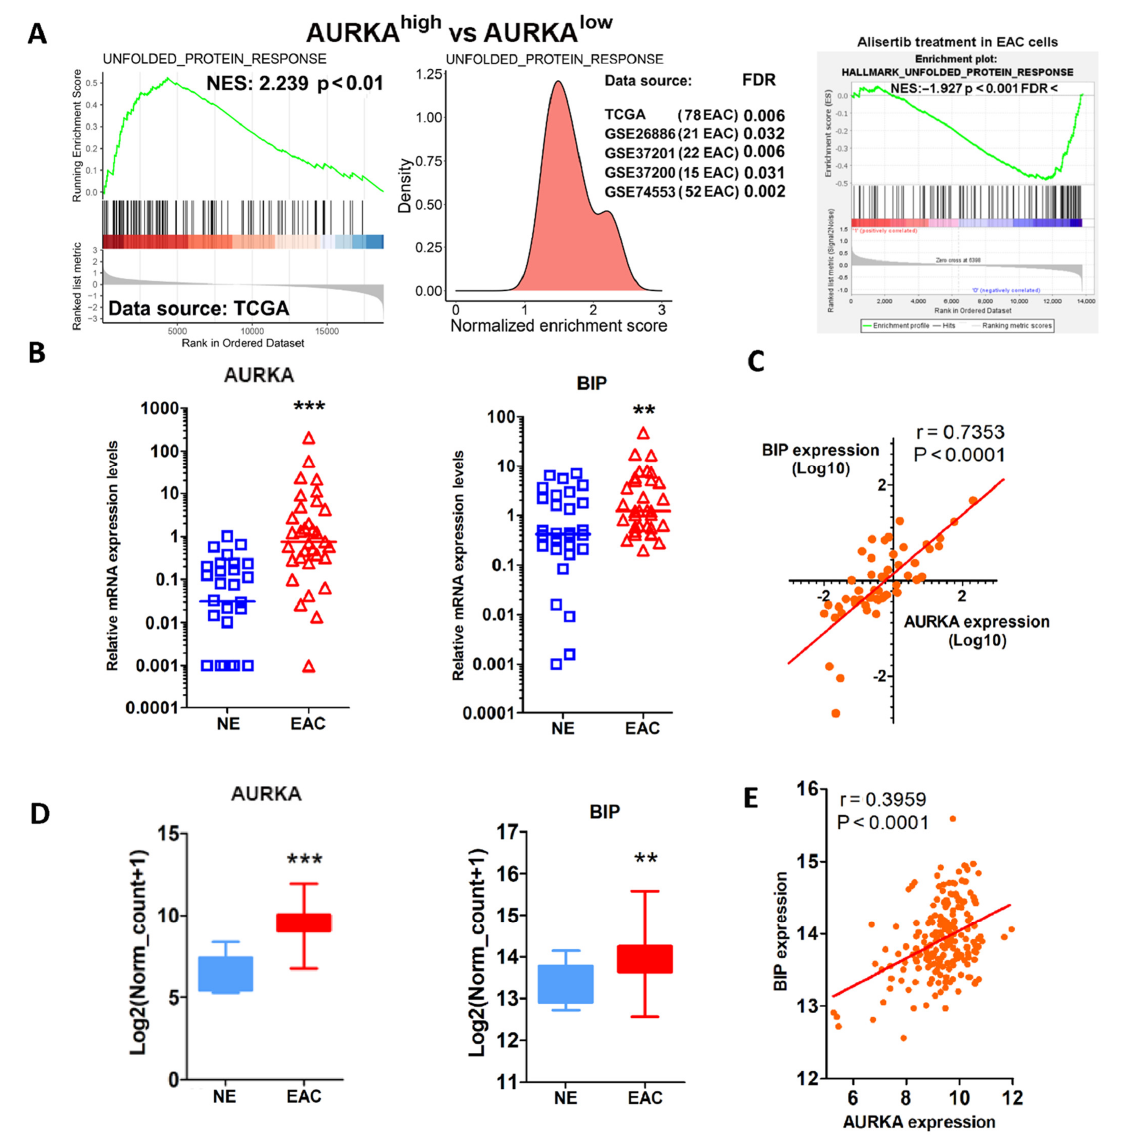
Figure 1. AURKA is positively correlated with UPR in EAC. ( A ) Left and middle panels: TCGA and GEO database analysis of signal pathway enrichment in AURKA high EAC compared with AURKA low EAC. Right panel: unfolded protein response gene set enrichment analysis in FLO-1, OE33, and SK-GT4 cell NGS data of alisertib treatment groups compared with control groups. ( B ) qRT-PCR analysis of AURKA and BIP mRNA expression in the normal human esophagus (NE) and esophageal adenocarcinoma (EAC) tissue samples. ( C ) Correlation between AURKA and BIP mRNA expression in esophageal tissue samples from ( B ). ( D ) Data analysis of AURKA and BIP mRNA expression in the normal esophagus (NE) and esophageal adenocarcinoma (EAC) samples from TCGA database. ( E ) Correlation between AURKA and BIP mRNA expression in esophageal tissue samples from TCGA database. ** p < 0.01, *** p < 0.001.